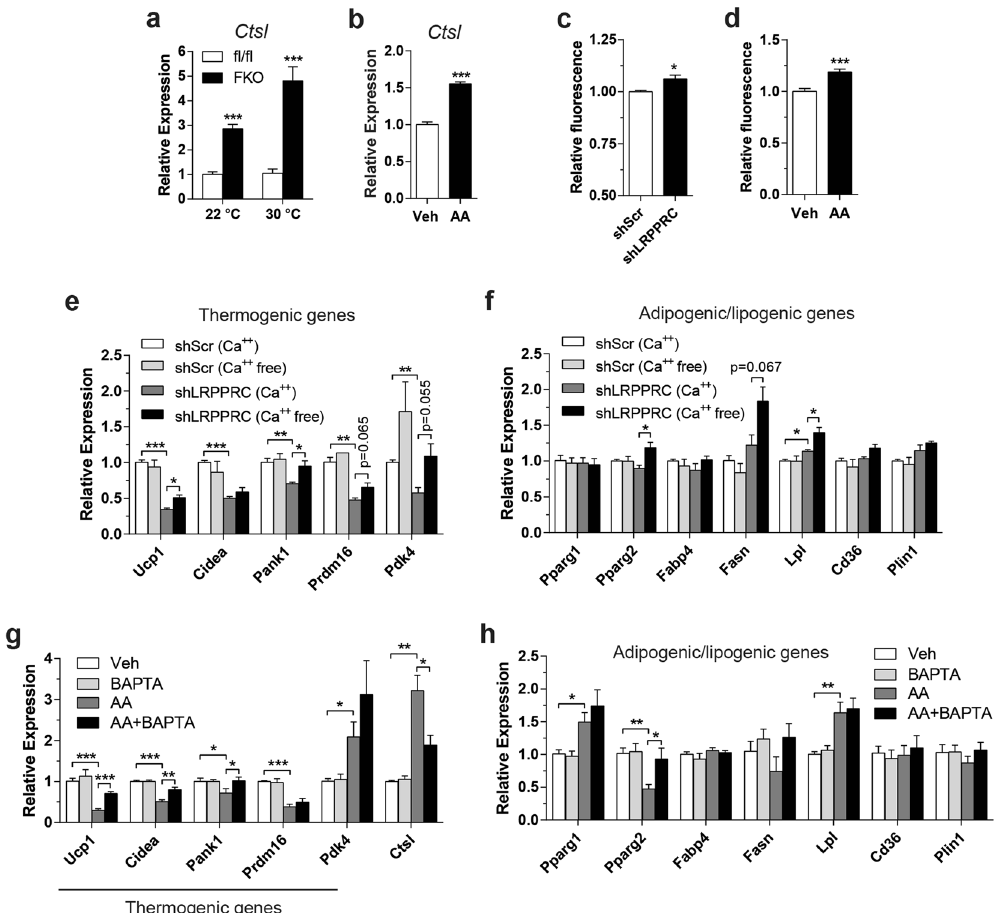
Figure 5. Cytosolic Ca 2 + may serve as a signaling mediator between mitochondria and nucleus. ( a , b ) mRNA levels of Ctsl in BAT ( a ) and primary brown adipocytes ( b ). ( c , d ) Measurement of cytosolic Ca 2 + in immortalized brown adipocytes with LRPPRC knockdown ( c ) or treated with AA ( d ) using a cell-permeable Ca 2 + -specific fluorescent indicator Fluo4-AM. ( e , f ) mRNA levels of thermogenic genes ( e ) and adipogenic/ lipogenic genes ( f ) in LRPPRC knockdown cells. Cells were incubated in Ca 2 + -free media supplemented with 100 μ M EGTA for 8–12 hr. ( g , h ) mRNA levels of thermogenic genes ( g ) and adipogenic/lipogenic genes ( h ) in immortalized brown adipocytes co-treated with AA and BAPTA. 40 μ M BAPTA-AM (a cell-permeable form of BAPTA) was loaded into cells for 1 hr, followed by treatment with 20 nM AA for 18 hr. ( a ) n = 3–5. Data are mean ± SEM. * P < 0.05, ** P < 0.01, *** P < 0.001, two-tailed unpaired Student’s t- test ( a – h